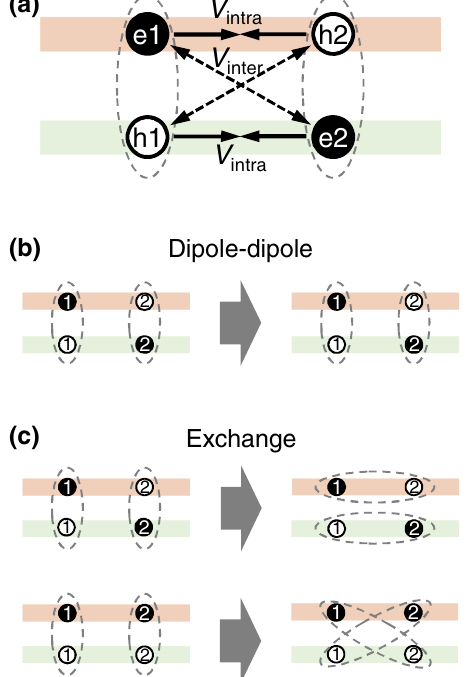
FIG. 6. (a) The Coulomb interaction between two X inter ð e 1 ; h 1 Þ and ð e 2 ; h 2 Þ . Solid (empty) circles denote the electrons (holes). V and V correspond to the interlayer and intralayer inter intra Coulomb interactions, respectively. (b) Schematic illustration of the dipole-dipole interaction, which corresponds to the process ð e 1 ; h 1 Þ þ ð e 2 ; h 2 Þ → ð e 1 ; h 1 Þ þ ð e 2 ; h 2 Þ . (c) Schematic illus- tration of the exchange interaction, which corresponds to the process ð e 1 ; h 1 Þ þ ð e 2 ; h 2 Þ → ð e 1 ; h 2 Þ þ ð e 2 ; h 1 Þ . Note that different electric dipole orientations of ð e 1 ; h 1 Þ and ð e 2 ; h 2 Þ can result in ð e 1 ; h 2 Þ and ð e 2 ; h 1 Þ with either intralayer (upper row) or interlayer configurations (lower